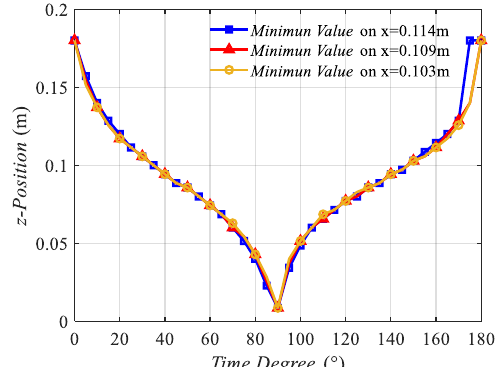
( , , ) H x z t on three side lines varying with time x